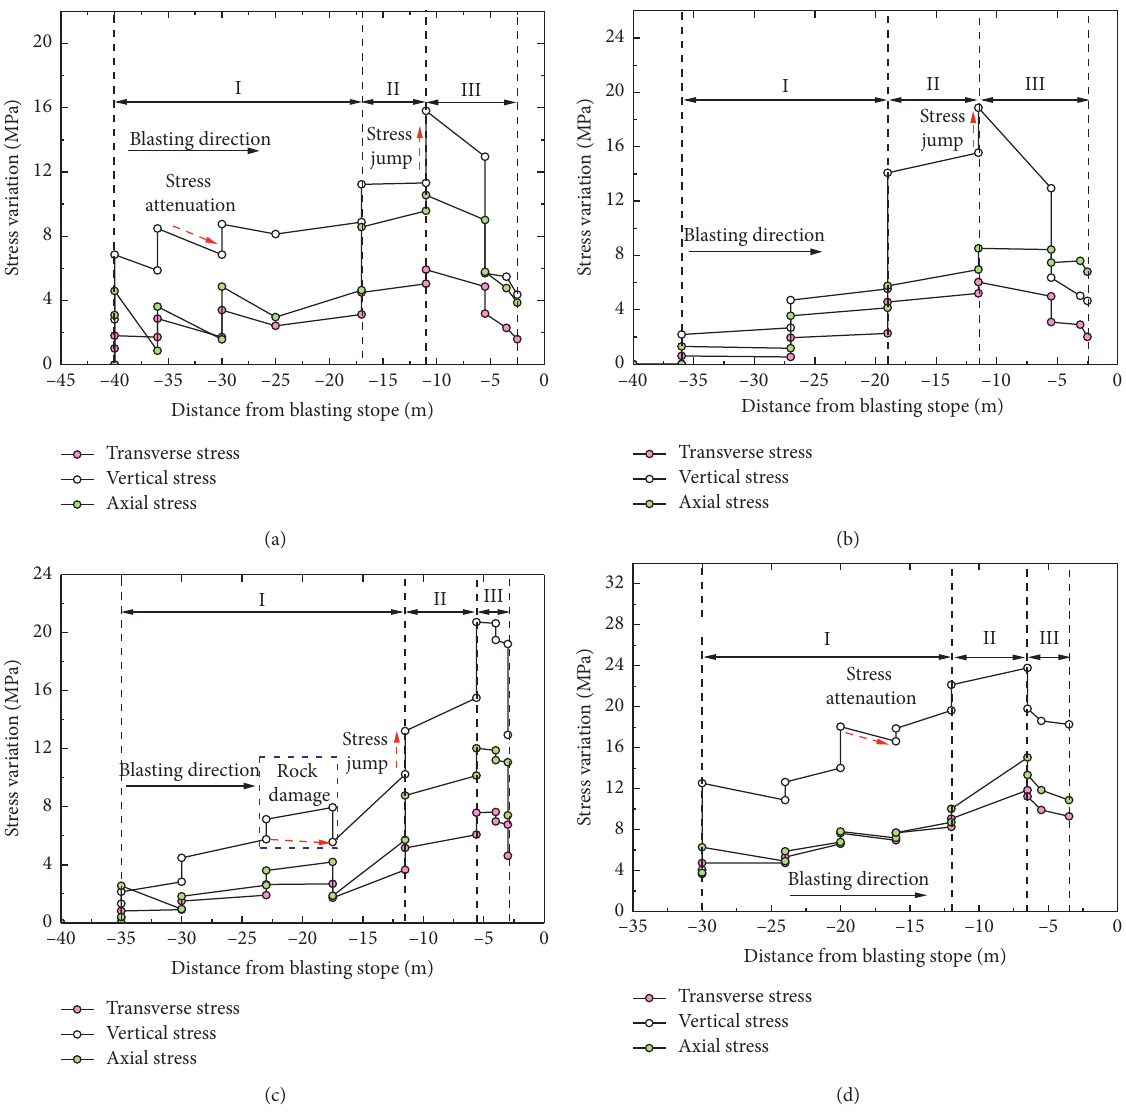
Figure 6: Evolution of horizontal mining stress in each horizontal section of 16-2 # stope. (a) − 325 horizontal section, (b) − 350 horizontal section, (c) − 375 horizontal section, and (d) − 400 horizontal